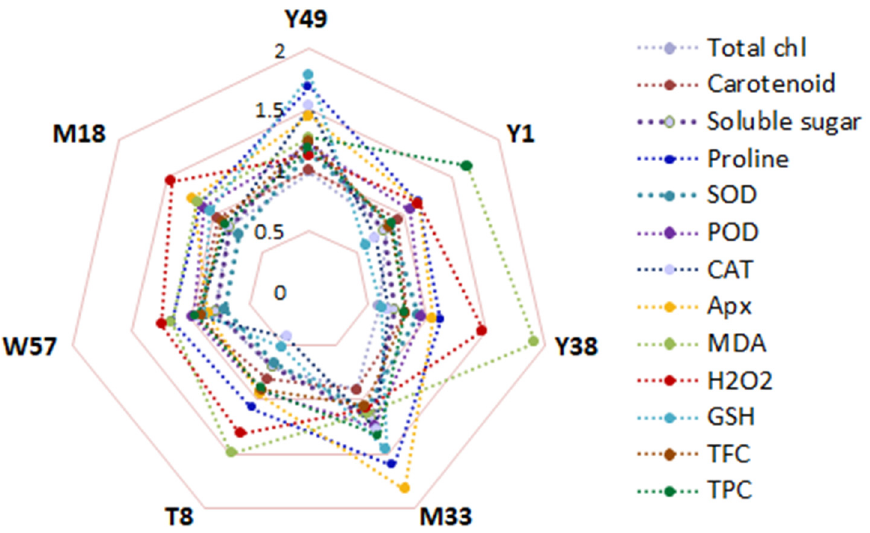
Figure 7. Radar plot represents the varietal variations in biochemical traits at low-temperature cold stress treatment.